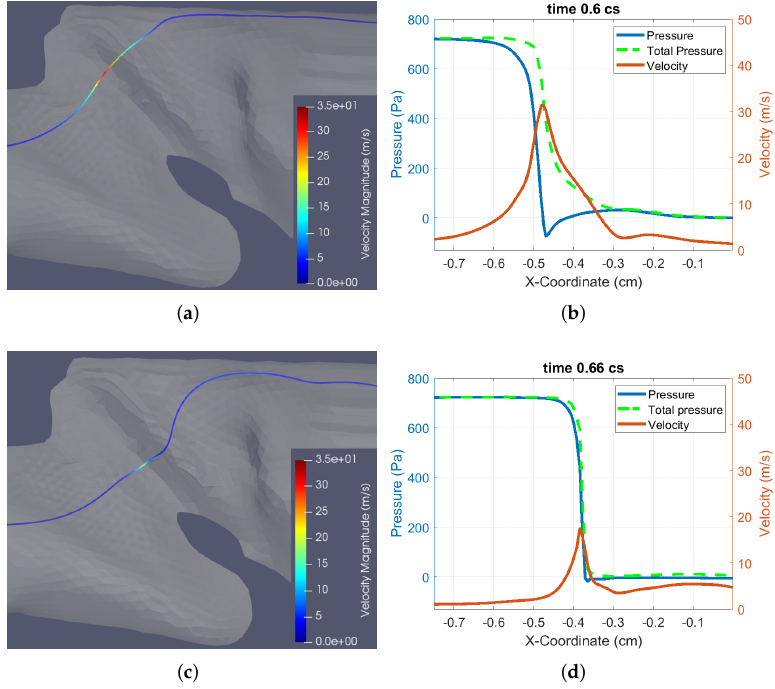
Figure 7. Change of the total pressure along a streamline at open or closed state for Sample 3. ( a ) A streamline at open state with t = 0.6 cs, and ( b ) the plots for p , V , and p total along this streamline; ( c ) A streamline at closed state with t = 0.66 cs, and ( d ) plots for p , V , and p total along this